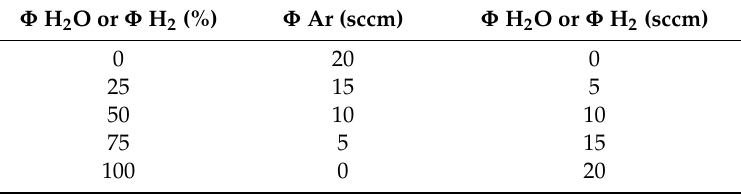
Figure 1. ( a ) Schematic representation of the asymmetric plasma reactor; ( b ) Photograph of discharge during a deposition process. Table 1. Gas feed composition employed during deposition processes.